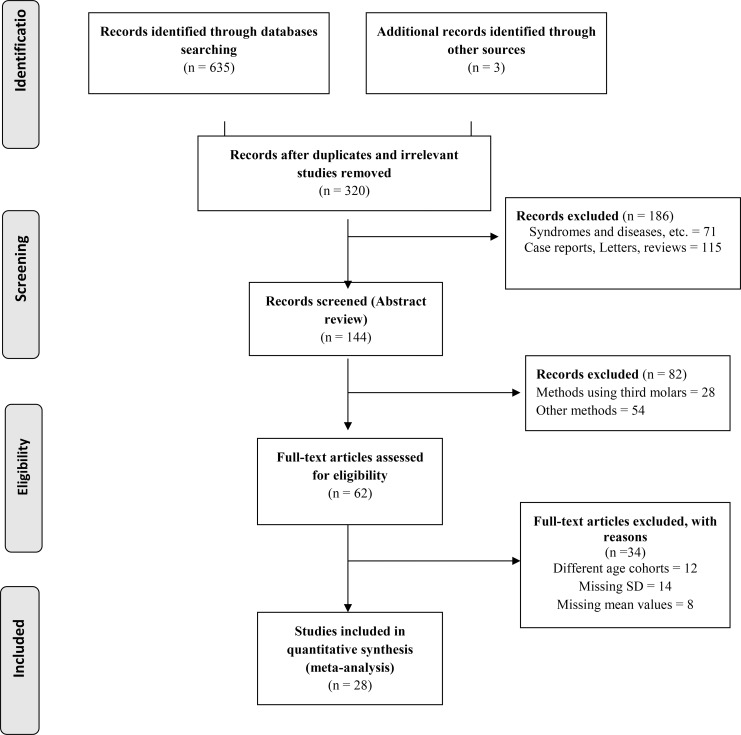
PRISMA 2009 flow diagram for systematic review with meta-analysis.